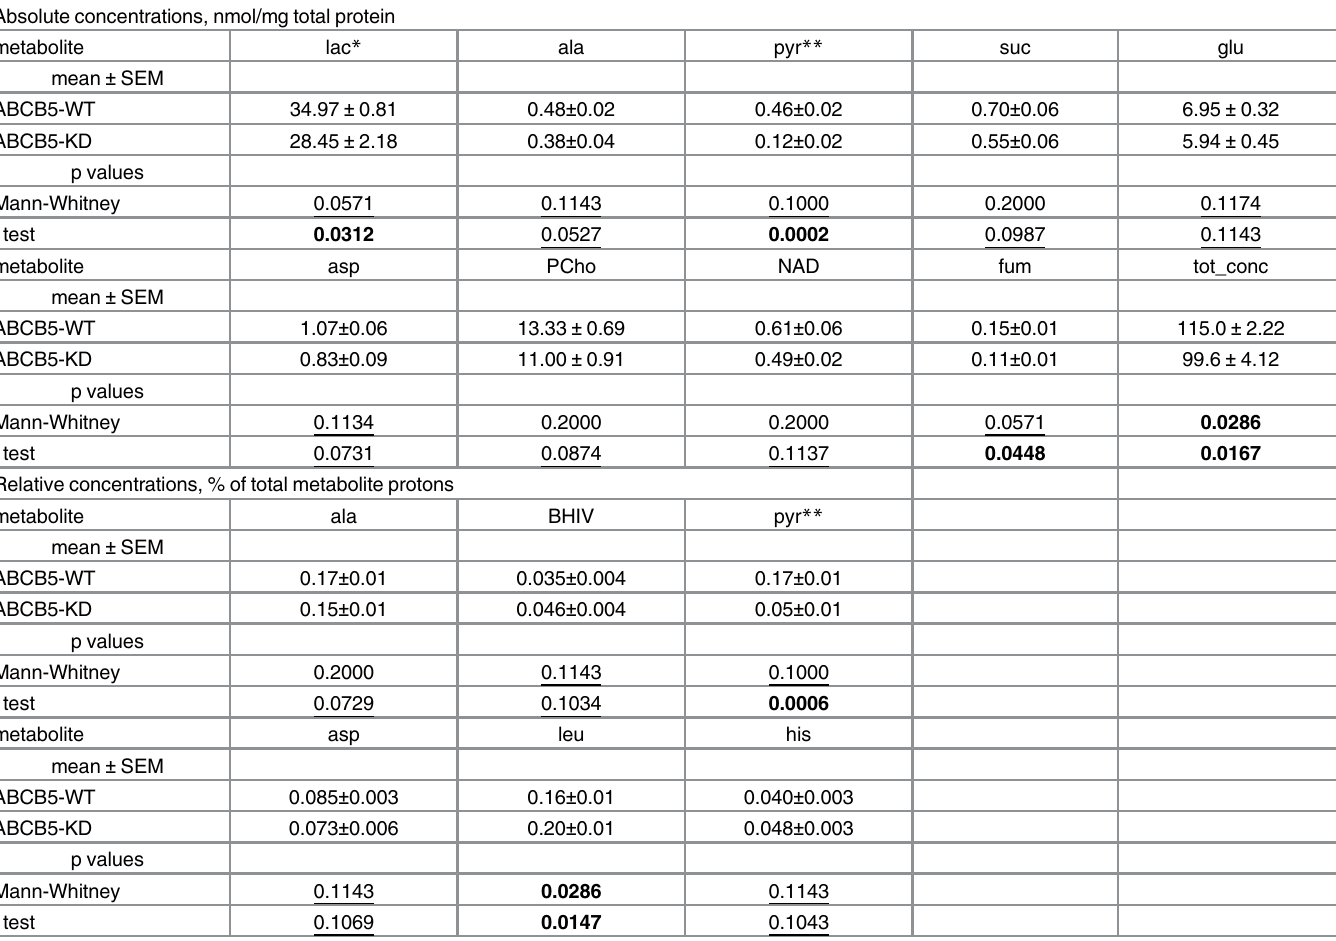
Table 1. Significant differences between levels of water-soluble metabolites in ABCB5-WT and ABCB5-KD G3361 melanoma cells based on 1 H NMR spectroscopy of cell